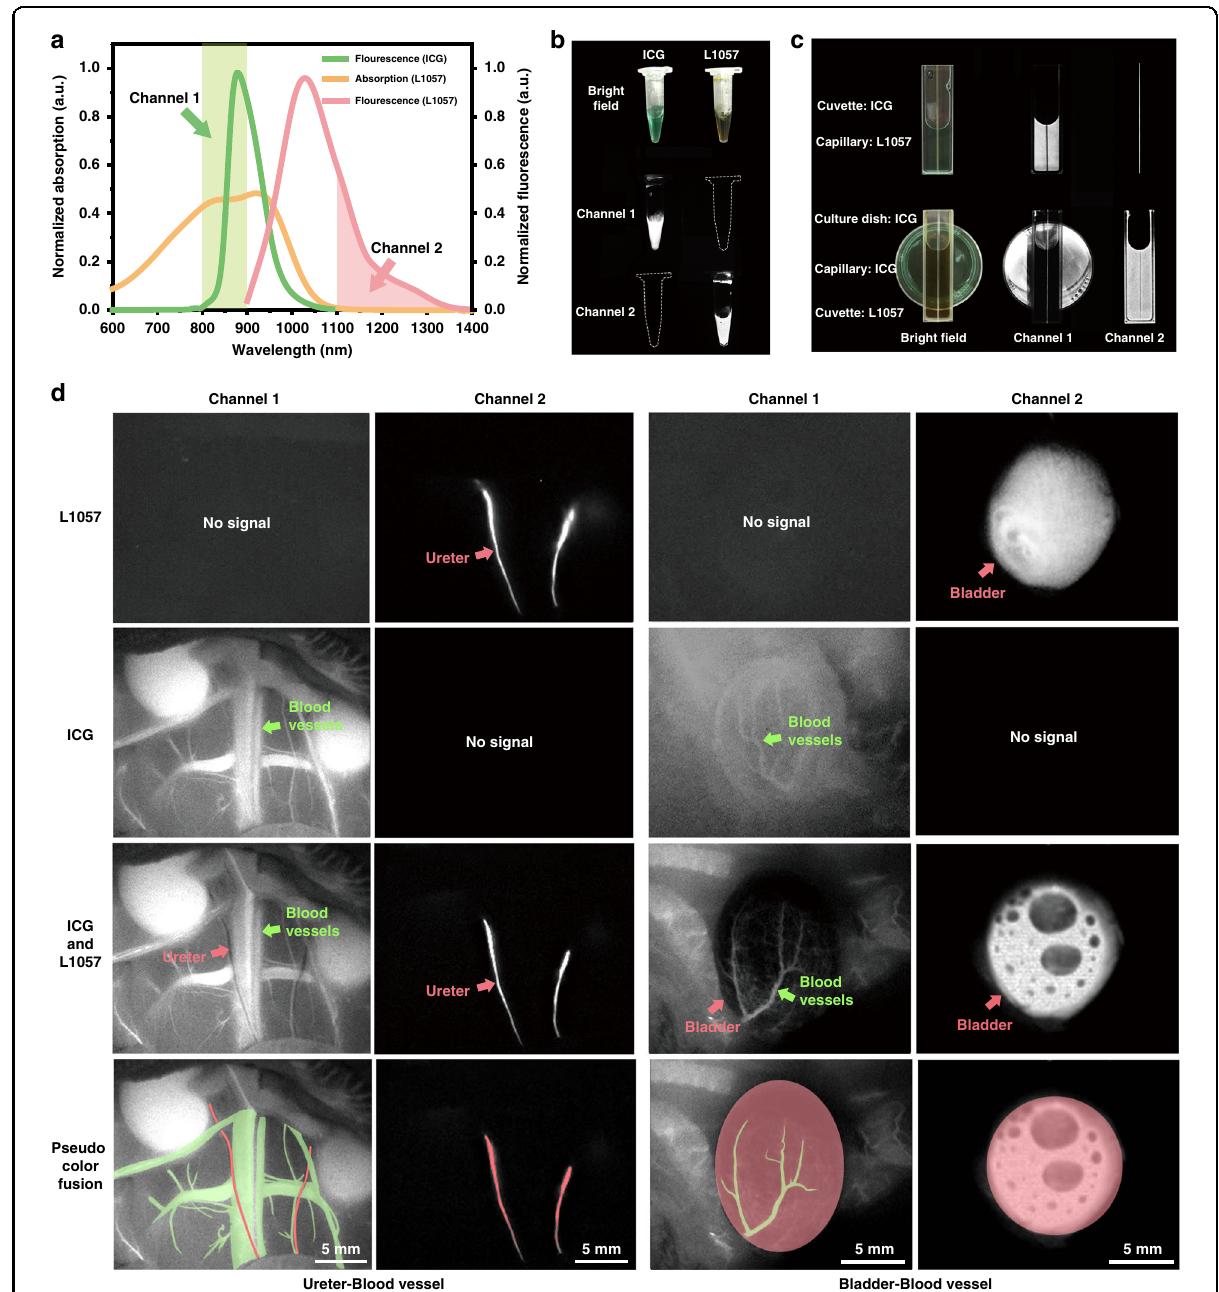
Fig. 5 Multi-mode imaging of urinary system and blood vessels under the excitation of a single light source. a The fl uorescence spectra of ICG in rat serum and L1057 NPs in water, and the absorption spectrum of L1057 NPs in water. b Bright- fi eld images and fl uorescence images of ICG (0.1mg mL − 1 in rat serum) and L1057 NPs (0.5 mg mL − 1 in water) in channel 1 and channel 2 respectively. Excitation: 915 nm CW laser, 13 mW cm − 2 ; exposure time: 25 ms for channel 1, 11 ms for channel 2. c In vitro simulation of multi-mode imaging. The upper part simulates the ureter-blood vessel scenario, where the capillary fi lled with L1057 NPs simulates the ureter, and the cuvette fi lled with ICG simulates underlying blood vessels and tissues. The lower part simulates the bladder-blood vessel scenario, where the capillary fi lled with ICG simulates the vessel on the bladder surface, the cuvette fi lled with L1057 NPs simulates the bladder, and the culture dish fi lled with ICG simulates the underlying tissues. Excitation: 915 nm CW laser, 13 mW cm − 2 ; exposure time: 25 ms for channel 1,15 ms for channel 2; dosage: 0.1 mg mL − 1 of ICG in rat serum, 0.5 mg mL − 1 of L1057 NPs in water. d Multi-mode imaging of rats treated with ICG and L1057 NPs under the excitation of a 915 nm CW laser. In channel 1: excitation: 15 mW cm − 2 ; exposure time: 25 ms. In channel 2: excitation: 55 mW cm − 2 ; exposure time: 30 ms. Dosage: ICG (2 mg mL − 1 , 300 μ L), L1057 NPs (0.15 mg mL − 1 , 1 mL). Scale bar: 5